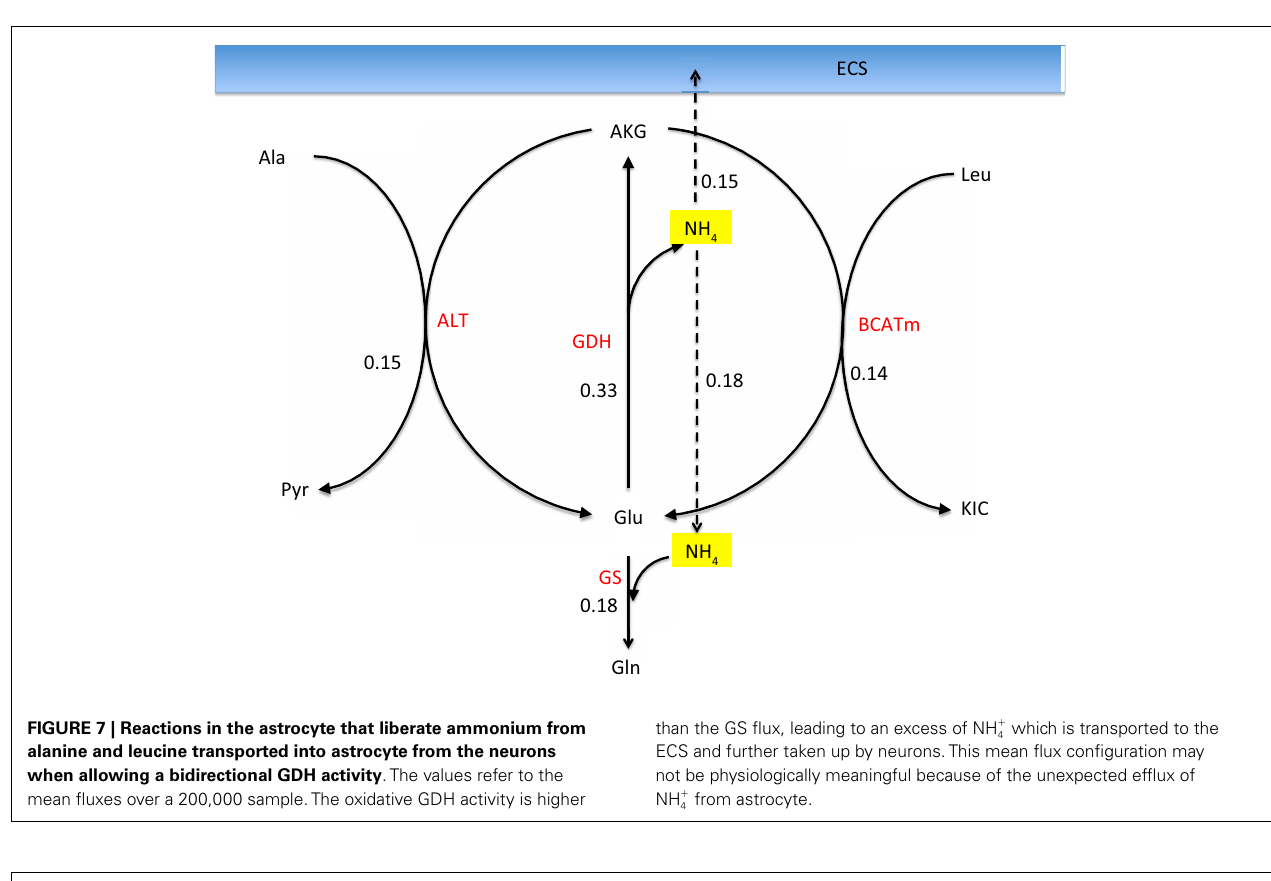
FIGURE 7 | Reactions in the astrocyte that liberate ammonium from alanine and leucine transported into astrocyte from the neurons when allowing a bidirectional GDH activity .The values refer to the mean fluxes over a 200,000 sample.The oxidative GDH activity is higher